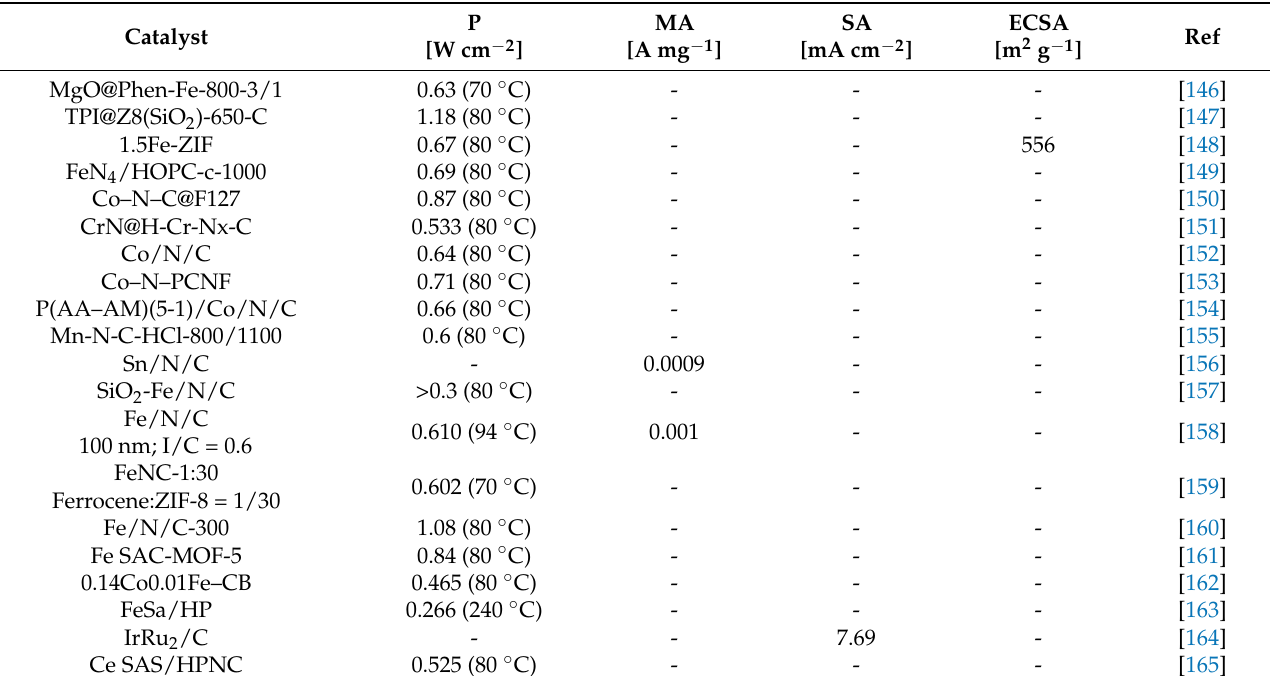
Table 5. PGM-free-based catalyst for fuel cells application: Peak power density (P), mass activ- ity (MA), specific activity (SA) and electrochemical active surface areas for selected catalyst for each